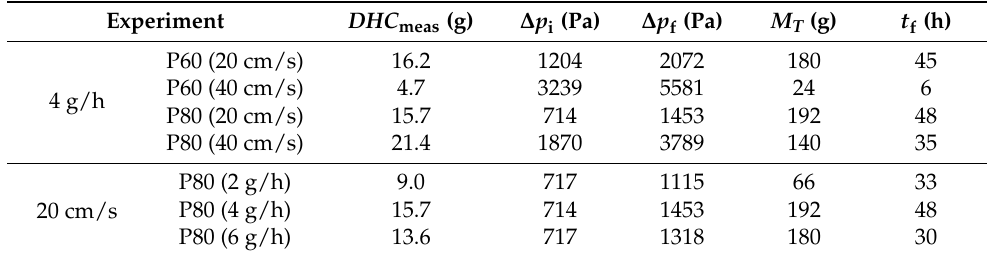
Table 2. Overview of the raw experimental data obtained at different experimental